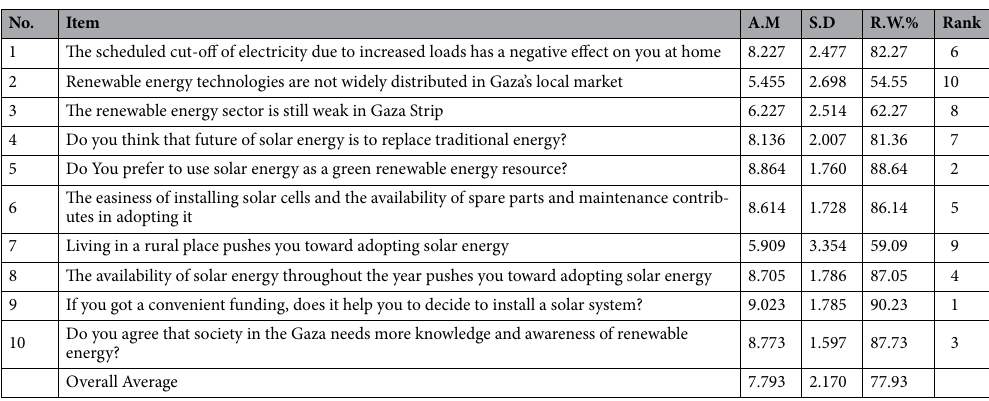
Table 4. Main reasons that affect decision to adopt solar systems.